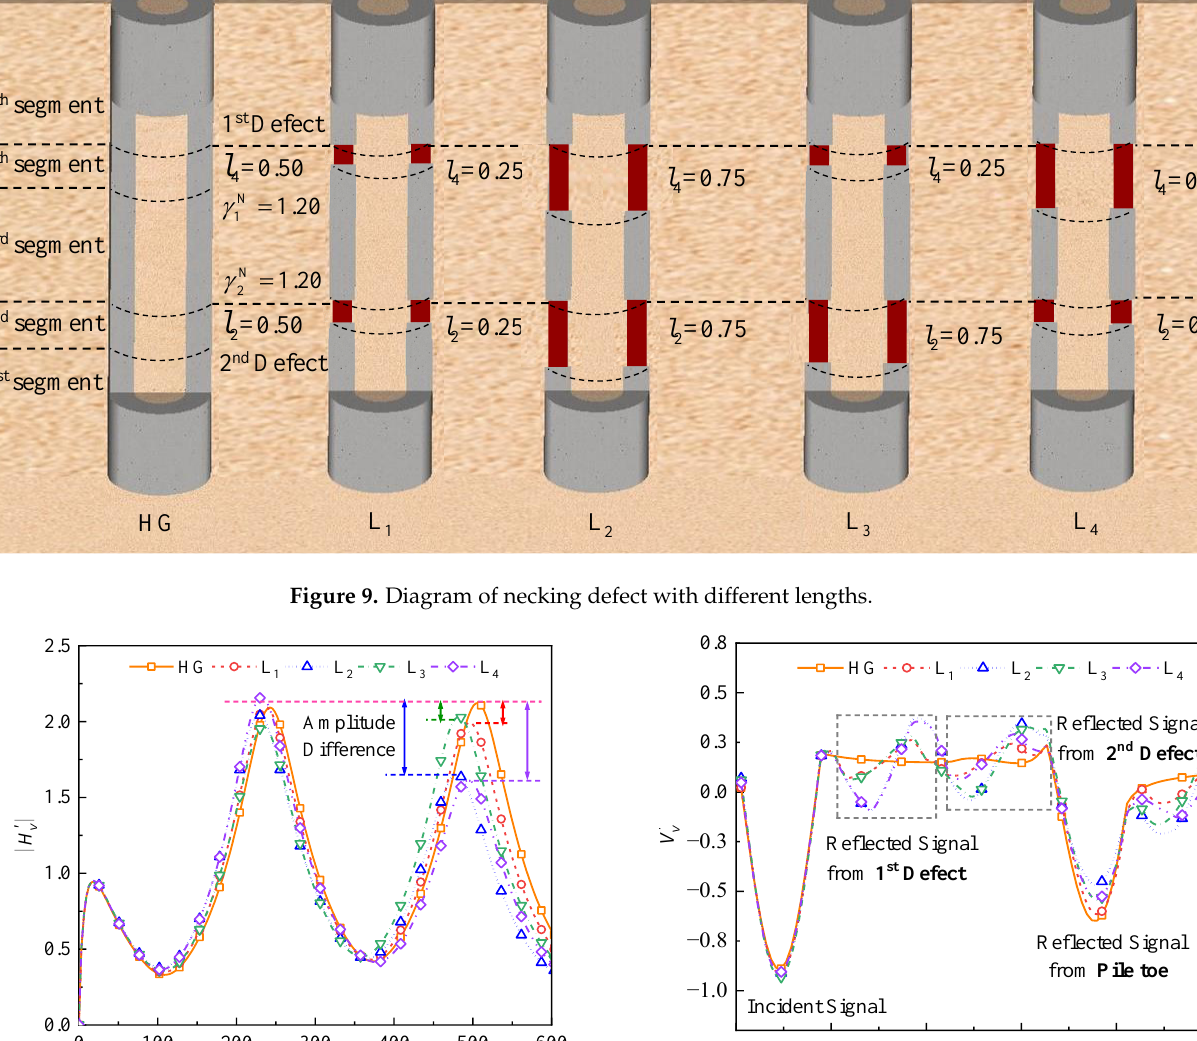
H  , ( b ) V  . Figure 10. Effect of the length of necking defects on the pipe pile response. ( a ) H (cid:48) v , ( b ) V (cid:48) v v v